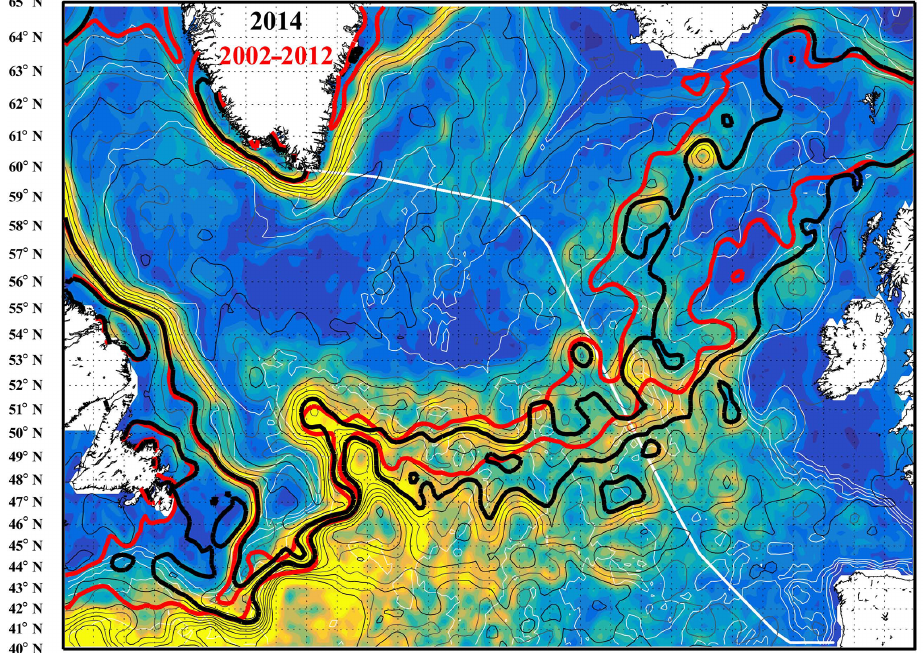
Figure 8. Contours of the absolute dynamic topography (ADT) averaged over 2014 (in thin lines); contours are every 0.05m. Thick contours correspond to the levels encompassing the SAF during OVIDE cruises: red for the mean 2002–2012 and black for 2014. Note that the temporal trend in the mean ADT over the whole box (2.8mmyr − 1 ) was removed. Bathymetry (1000m step contours) and the OVIDE section are plotted in white. Colors represent the absolute velocity of the current (yellow for velocities stronger than 0.3ms − 1 ) . Table 1. Intensity (top-to-bottom integrated) of the different dynamical structures defined in Sect. 3.1 for 2014 and the mean values (2002– 2012) estimated by Daniault et al. (2016). Note that the errors given for the GEOVIDE estimates come from the covariance matrix resulting from the inverse model. Otherwise, the errors given with the mean values are the standard deviation of the six estimates of each current. Units:Sv WBC IG IC ERRC NAC Recirculation as D2016 Northward transport